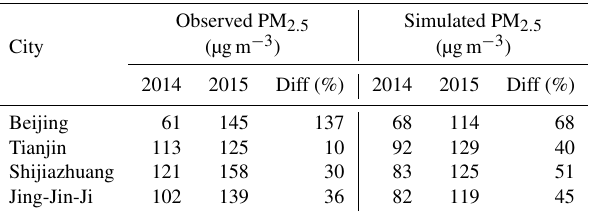
age PM 2 . 5 concentrations are shown in Fig. S2. The error in December 2015 is larger than in December 2014, which may